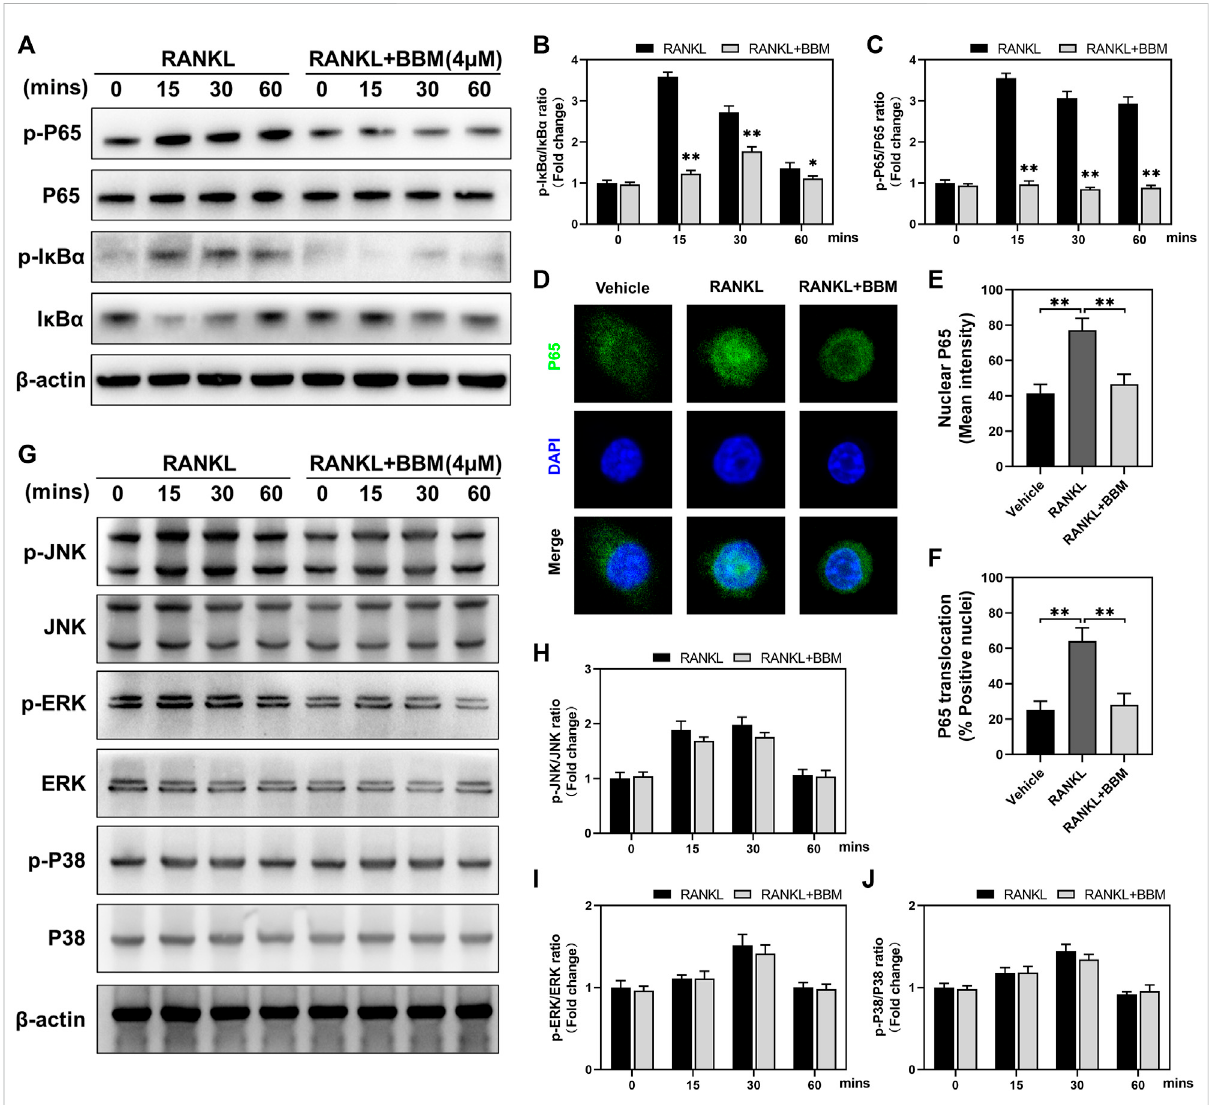
FIGURE 4 BBM inhibits RANKL-induced activation of the NF- κ B signaling pathway. (A) Representative western blotting images of P65, p-P65, I κ B α and p-I κ B α afterstimulationwithorwithout4 μ MBBMfortheindicatedtime. (B – C) Quantitativeanalysisofthep-P65/P65ratio (B) andp-I κ B α /I κ B α ratio (C) at each indicated time point. (D) Representative confocal images of the P65 nuclear translocation assay in BMMs treated with or without 4 μ M BBM. (E – F) Quantitative analysis of the mean P65 fl uorescence intensity in the nucleus (E) and the percentage of P65-positive nuclei (F) . (G) Representative western blotting images of JNK, p-JNK, ERK, p-ERK, P38 and p-P38 after stimulation with or without 4 μ M BBM for the indicated time. (H – J) Quantitative analysis of the p-JNK/JNK ratio (H) , p-ERK/ERK ratio (I) and p-P38/P38 ratio (J) at each indicated time point. * p < 0.05 and ** p < 0.01 compared to the control